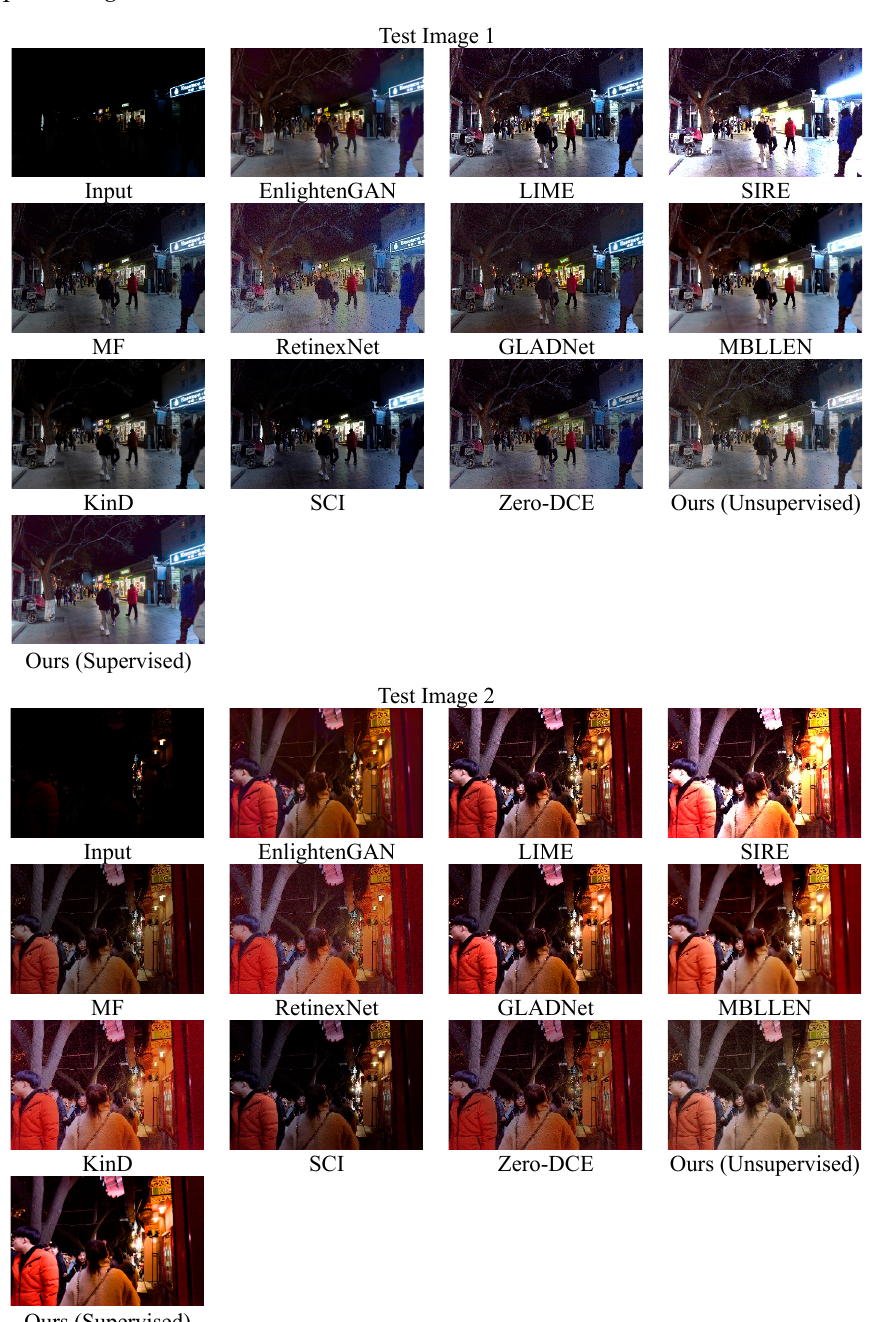
Figure 8. Comparison of the Effects in Low-Light Conditions.